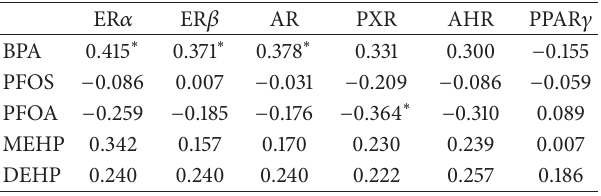
Table 4: Correlation between ECD and receptor expression in fer- tile